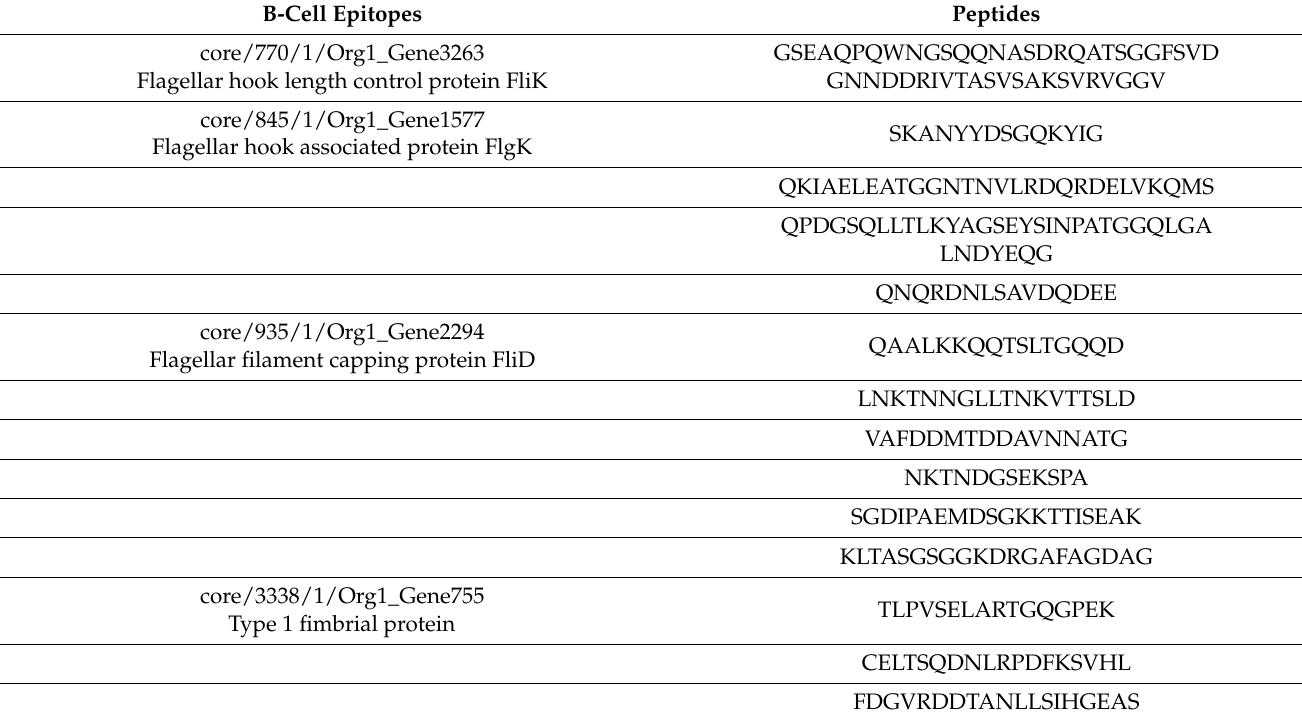
Table 6. Shortlisted vaccine targets and predicted B-cell